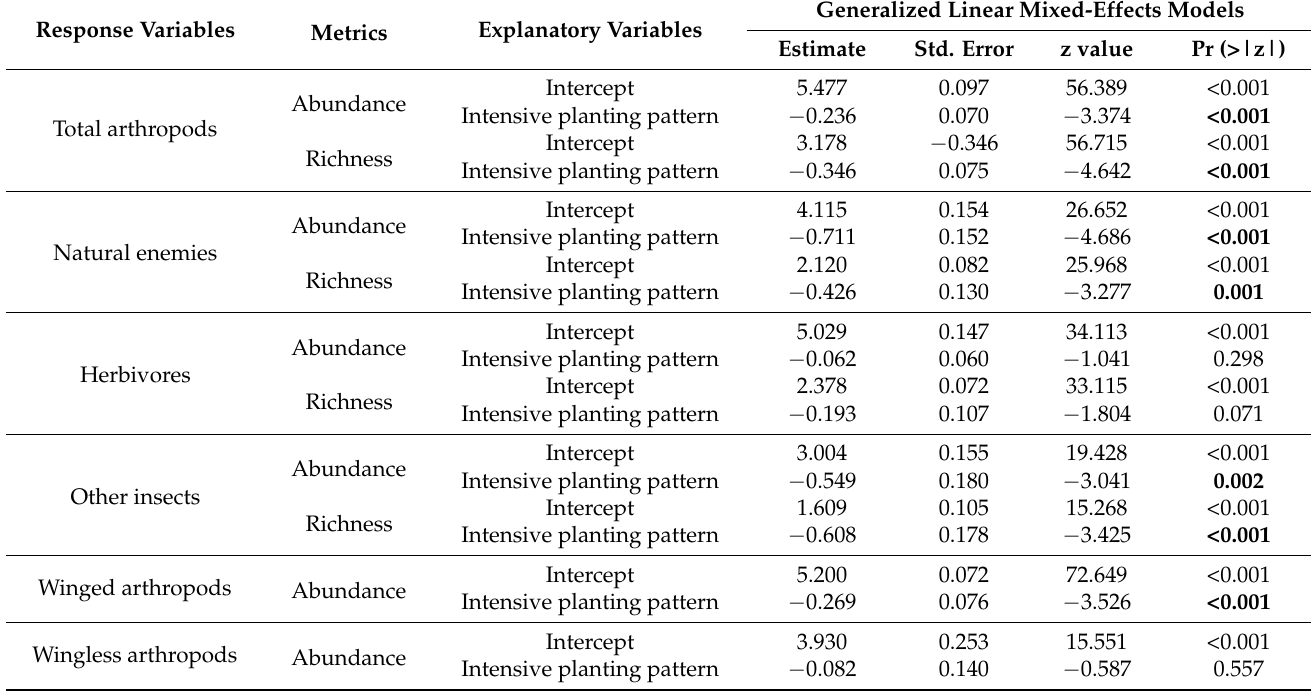
Table 1. Statistical results of generalized linear mixed-effects models (GLMMs) for the abundance and richness of vegetation- dwelling arthropods in naked oat fields under different planting patterns. Significant p -values are printed in bold. Response